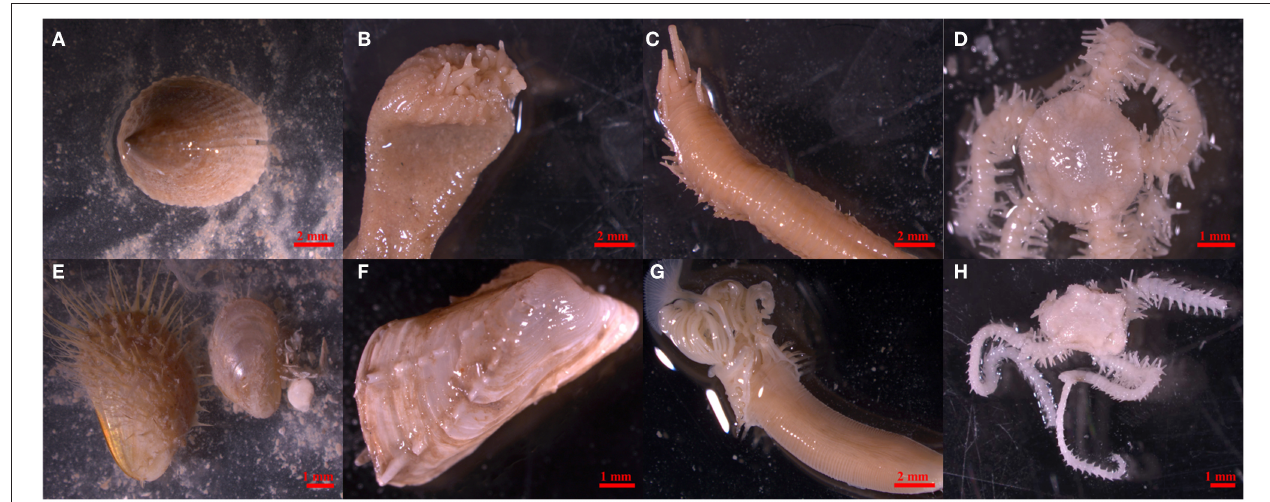
FIGURE 1 | Study organisms Emarginula fissure (A) , Parazoanthus anguicomus (B) , Eunice norvegica (C) , Ophiactis balli (D) , Modiolula phaseolina (E) , Hiatella arctica (F) , Serpula vermicularis (G) , and Ophiura ophiura (H) (From left to right, top to